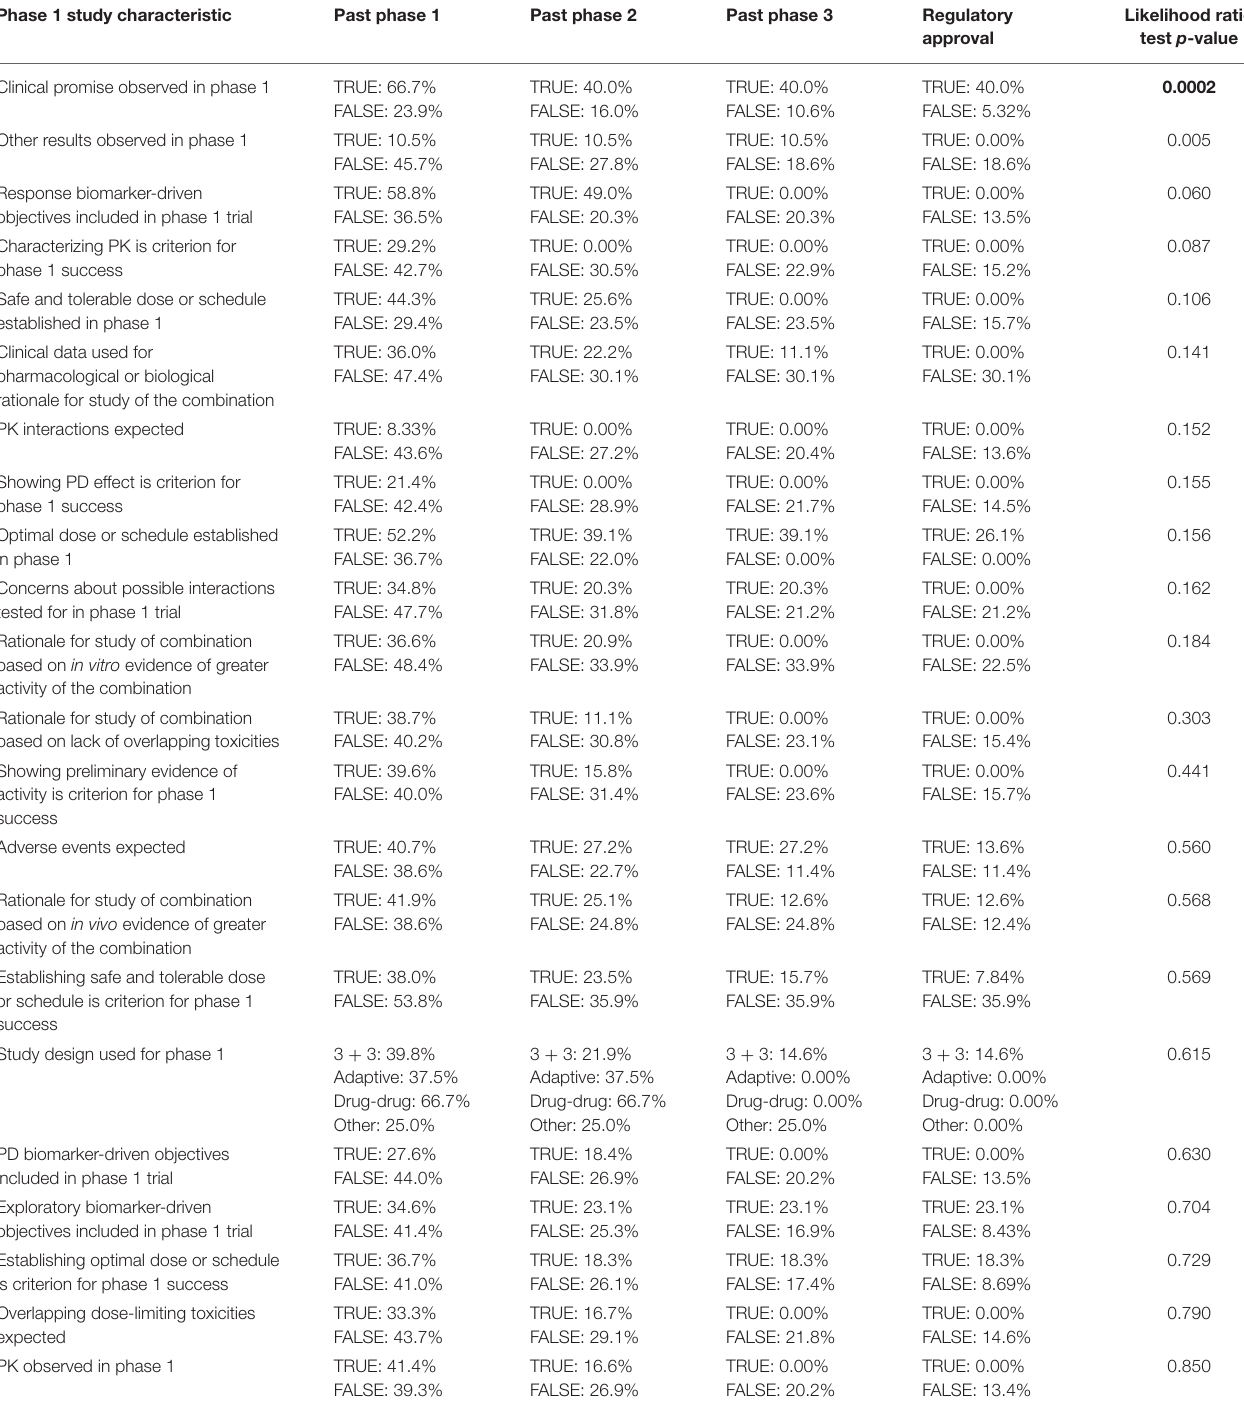
TABLE 5 | Probabilities of successfully achieving each milestone toward regulatory